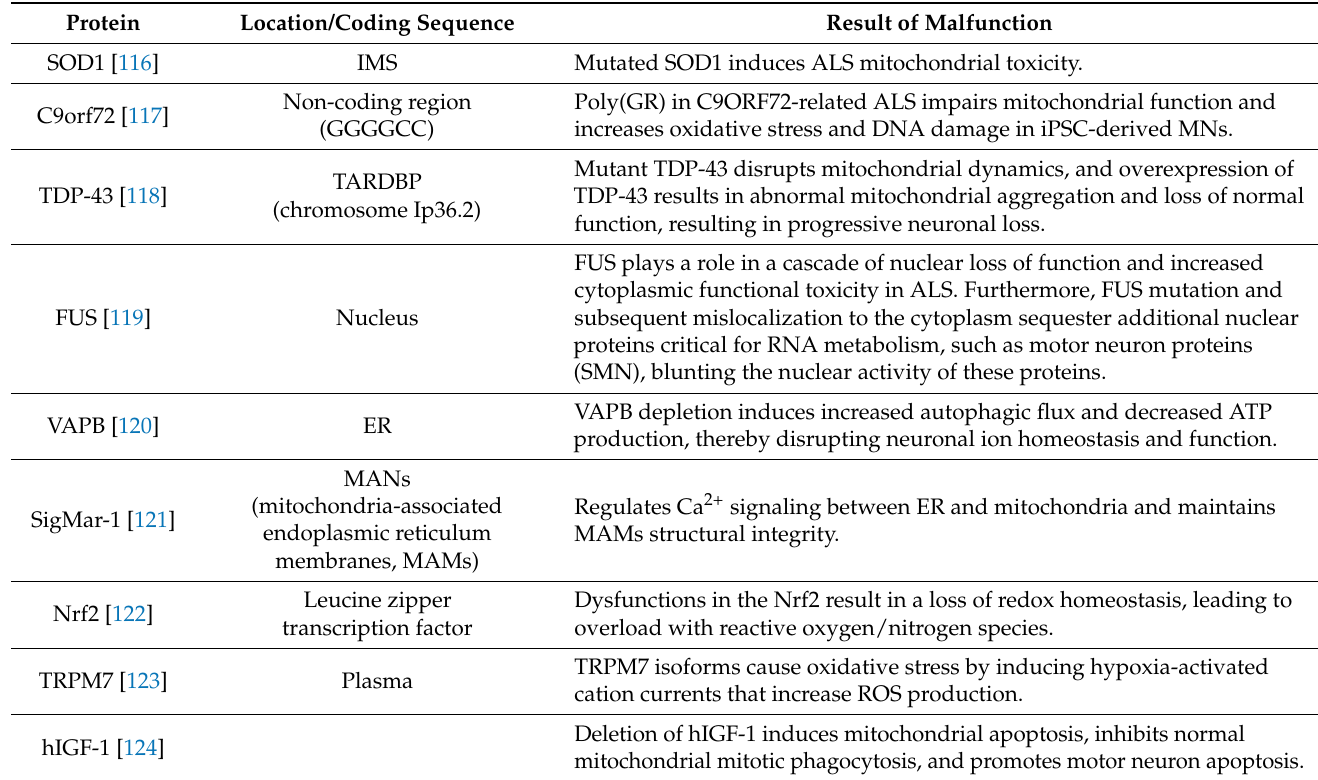
Table 2. Genetic markers associated with mitochondrial dysfunction in ALS.